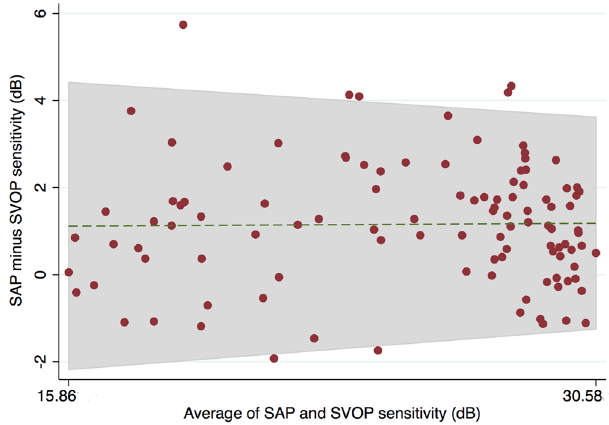
Figure 3. Bland Altman plot for visual field sensitivity comparing standard automated perimetry (SAP) and saccadic vector optokinetic perimetry